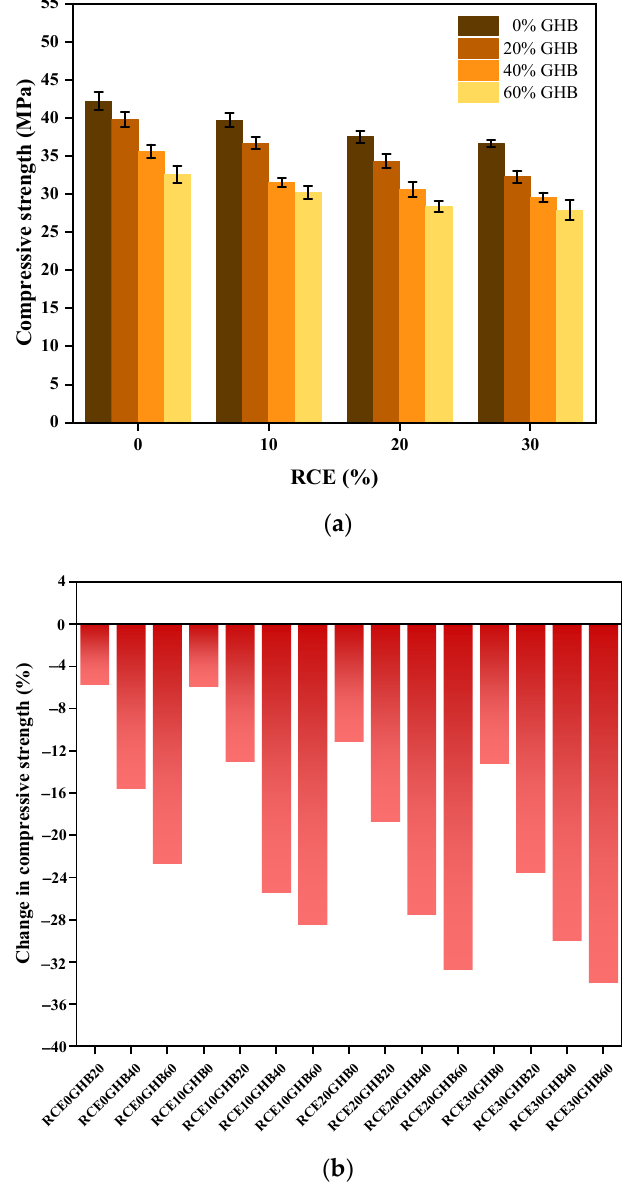
Figure 8. The experimental results and changes of compressive strength subject to the coupling influence between GHB and RCE on RTIC. ( a ) The experimental results of compressive strength of RTIC; ( b ) the changes of compressive strength of RTIC.